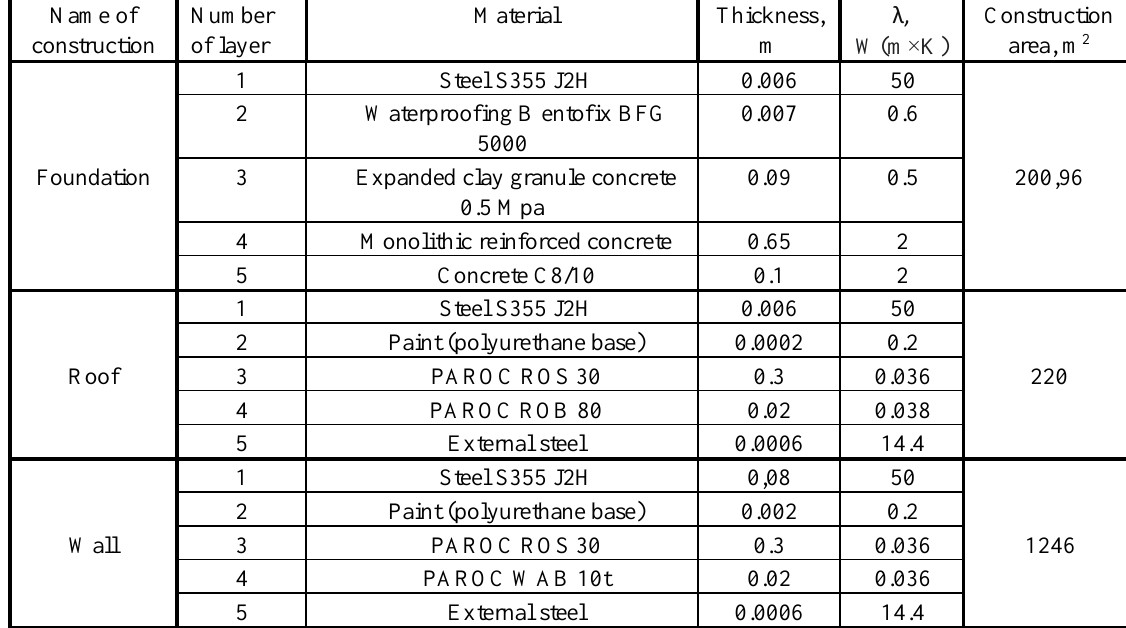
Table 1. Geometrical dimensions of heat accumulator and specification of enclosing structures [21] Name of construction